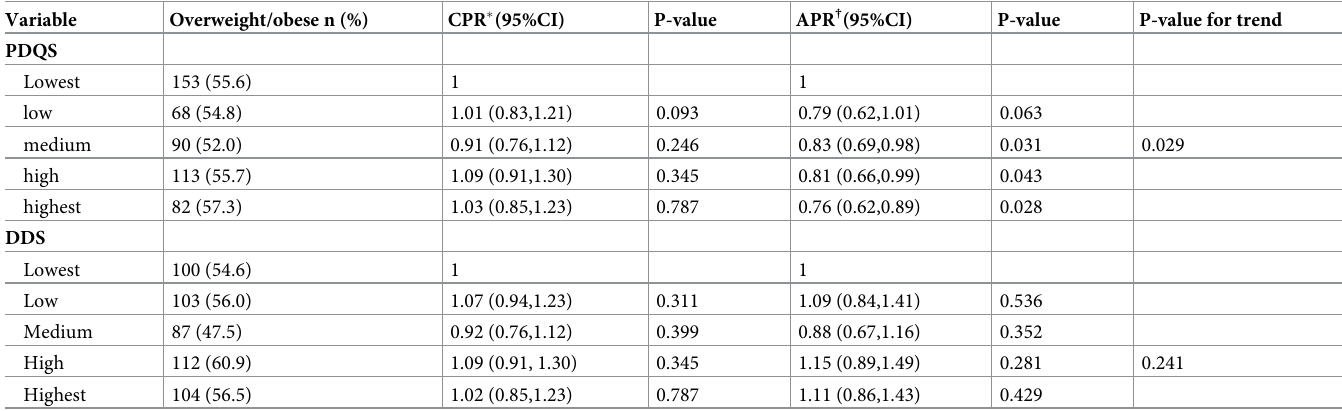
Table 4. Association between dietary quality and diversity with overweight and obesity (N = 918).